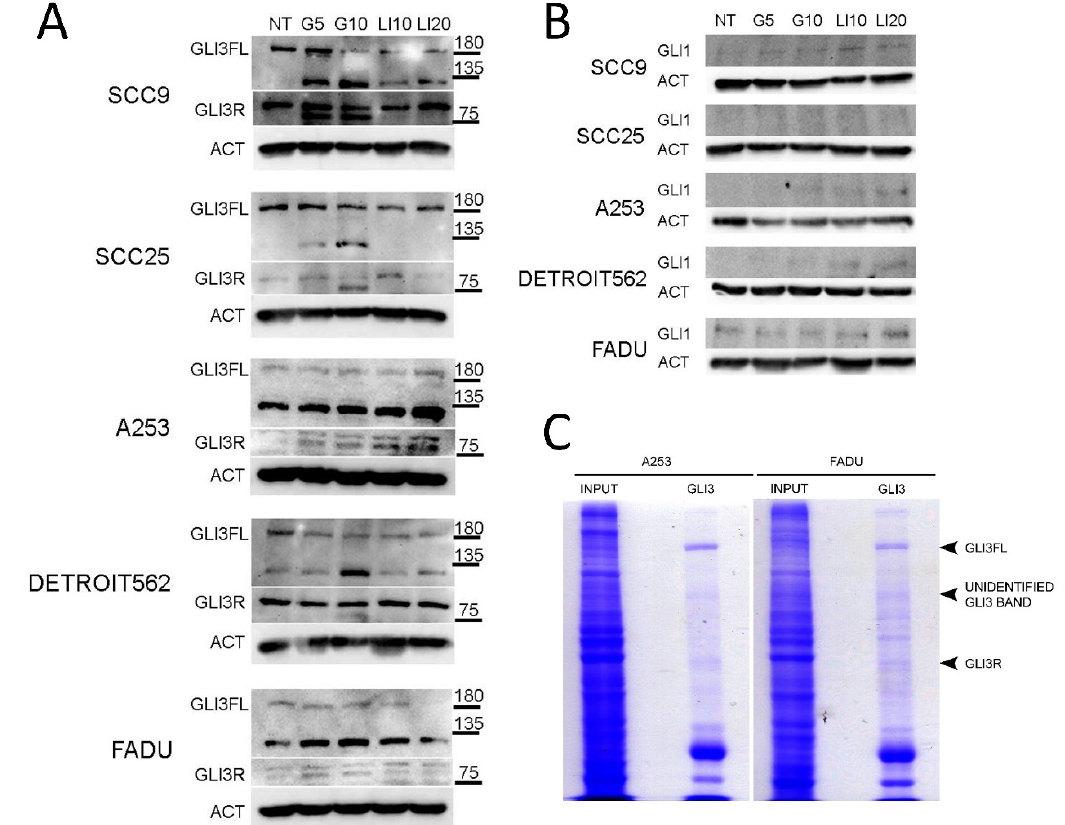
Figure 3. The effect of GANT61 and LiCl treatment on the expression of GLI proteins. ( A ) GLI3 and ( B ) GLI1 protein expression after treatment with HH-GLI pathway inhibitors GANT61 and LiCl (G5— 5 μ M GANT61, G10—10 μ M GANT61, LI10—10 mM LiCl, LI20—20 mM LiCl). ( C ) Coomassie gel (G5—5 µ M GANT61, G10—10 µ M GANT61, LI10—10 mM LiCl, LI20—20 mM LiCl). ( C ) Coomassie